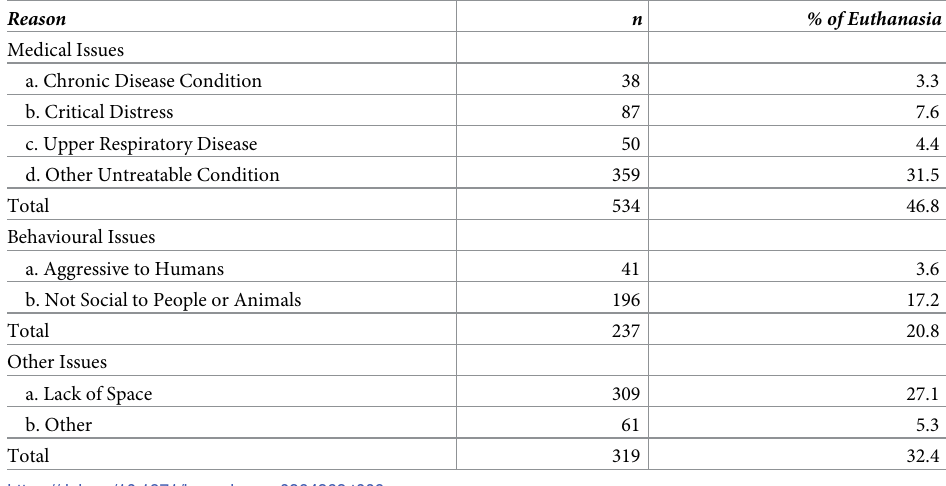
Table 6. Reasons given for euthanasia (N =